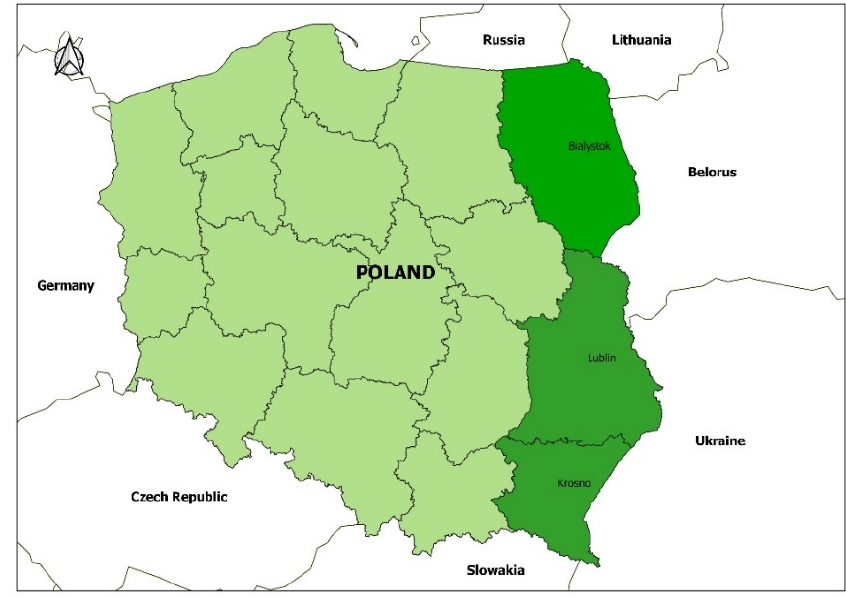
Figure 1. Location of the regional directorates of State Forests in Bia ł ystok, Krosno and Lublin. SFRD Bia ł ystok administers an area of 625,222 ha with a forest cover of 29.6%; SFRD Krosno administers 418,250 ha with a forest cover of 36.3%, and SFRD Lublin administers 420,400 ha with a forest cover of 22.2%. The studied area is quite varied in terms of forest site types (FSTs): montane FSTs occupy 160.9 thousand ha (11.9% of the total), upland FSTs cover 122.0 thousand ha (9.1%), while lowland FSTs occupy 1064.1 thousand ha, ac- counting for the largest share of the study area (79.0%). These proportions roughly reflect the distribution of FSTs on the scale of the whole country. In terms of the main forest tree species, the greatest area is occupied by Scots pine (695.3 thousand ha, or 52.0% of the overall study area), followed by oaks (110.1 thousand ha, or 8.2%), European beech (103.9 thousand ha, or 7.8%), birch (7.6%), Norway spruce (88.2 thousand ha, or 6.6%), and silver fir (78.7 thousand ha, or 5.9%). The average age of the studied stands (60 years) was higher than the average age of all stands managed by SFNFH (62 years in SFRD Bia ł ystok, 73 years in SFRD Krosno, and 65 years in Lublin SFRD). In 2015 SFRD Bia ł ystok harvested 2987.9 thousand m 3 of timber at a mean price of 182.31 PLN/m 3 , SFRD Krosno harvested 1886.2 thousand m 3 at 184.65 PLN/m 3 , and SFRD Lublin harvested 2056.2 thousand m 3 at 189.50 PLN/m 3 . The corresponding data for 2019 are 2952.5 thousand m 3 at 191.20 PLN/m 3 for SFRD Bia ł ystok, 2029.7 thousand m 3 at 199.74 PLN/m 3 for SFRD Krosno, and 2139.6 thousand m 3 at 199.39 PLN/m 3 for SFRD Lublin [64,65]. 2.2. Data The source of data for the present study was financial documentation from 82 SFNFH forest districts. The following information from the State Forest Information System (SILP) was made available by SFNFH bureaus as well as SFRD Bia ł ystok, SFRD Krosno, and SFRD Lublin for the years 2005–2009 and 2015–2019: (1) revenues, costs, and financial re- sults excluding Forest Fund transfers (2) basic financial statement items, such as State For- ests equity, fixed and working assets, and liabilities; (3) annual reports on forest district activity (LPIR-1); (4) economic analyses concerning the performance of SFRDs, and (5) timber sales reports (“Acer”—LPIO-9). The financial statements of individual forest dis- tricts (balance sheets, profit and loss accounts, and cash flows) for the years 2005–2009 and 2015–2019 were also used.